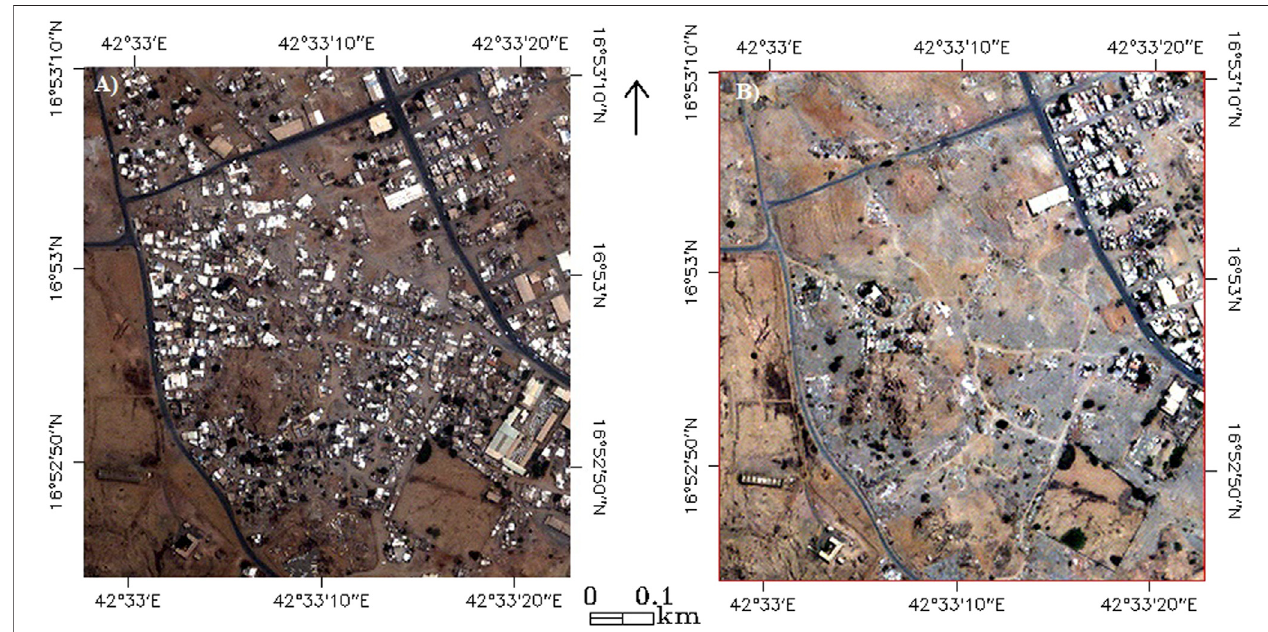
FIGURE 5 | The QuickBird-2 color composite images (R:3; G:2; B:1) showing pre-event (A) , and (cid:1) post-event (B) of Al-Shaima neighborhood.